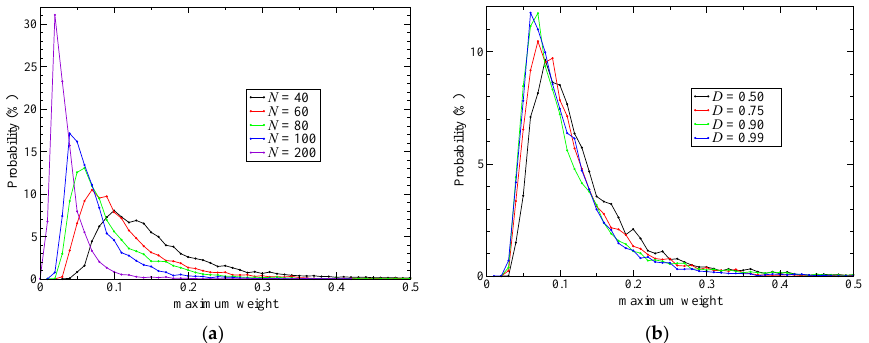
Figure 2. Distribution of the maximum value, σ max ( t ), sampled over 100 ps MD simulations where respective partitionings contain 1 QM solute and 32 QM solvent molecules. ( a ) The black, red, green, blue and purple lines represent the simulations with 40, 60, 80, 100 and 200 partitionings, respectively. All the simulations employed D = 0.75; ( b ) The black, red, green and blue lines represent the results from the simulations with D = 0.50, 0.75, 0.90 and 0.99, respectively; all the simulations were performed with 60 partitionings.